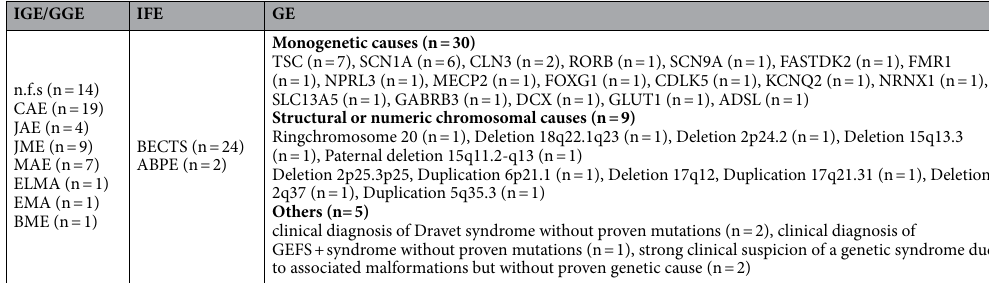
Table 2. Epilepsy syndrome classification. IGE/GGE, idiopathic/genetic generalized epilepsy; IFE, idiopathic focal epilepsy; GE, genetic epilepsy; n.f.s., not further specified; CAE, childhood absence epilepsy; JAE, Juvenile Absence Epilepsy; JME, Juvenile Myoclonic Epilepsy; MAE, Myoclonic Absence Epilepsy; ELMA, Epilepsy with Myoclonic Absences; EMA, Eyelid Myoclonia with Absences; BME, Benign Myoclonic Epilepsy; BECTS, Benign Epilepsy with Centro-Temporal Spikes; ABPE, Atypical benign partial epilepsy; TSC, Tuberous Sclerosis Complex; GEFS+, Genetic Epilepsy with Febrile Seizures+, all others are abbreviations of genes adhering to the HUGO Gene Nomenclature Committee’s guidelines 39